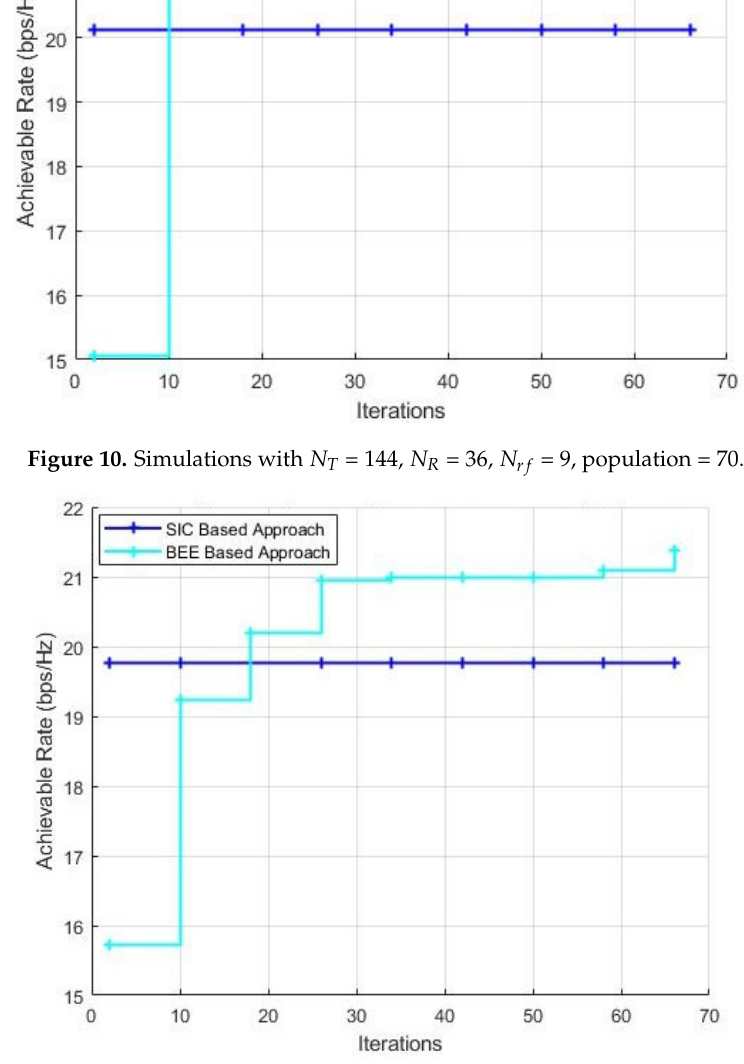
Figure 11. Simulations with N T = 144, N R = 36, N rf = 9, population =